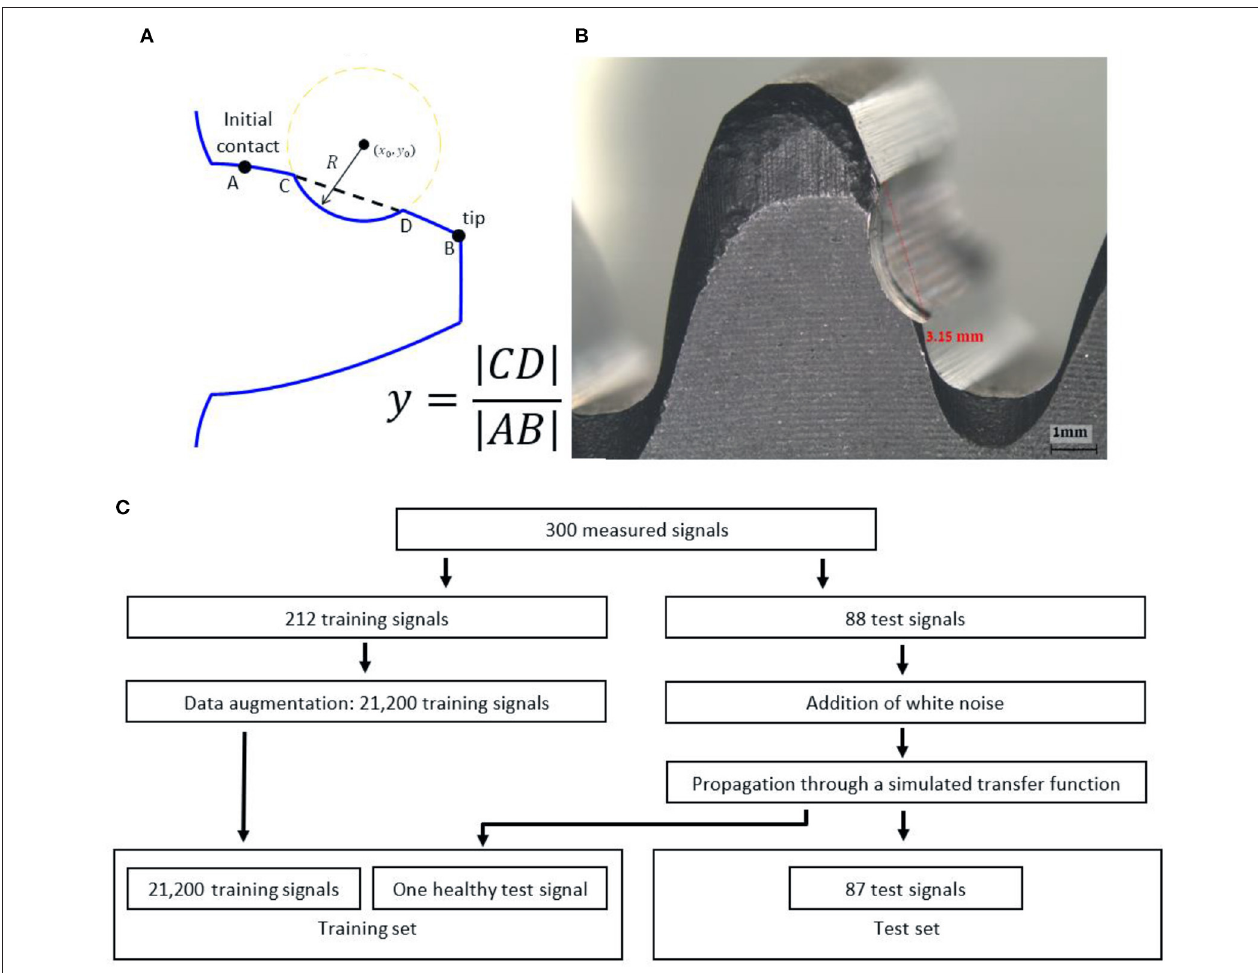
FIGURE 7 | Description of the dataset and explanation of the fault size. (A) Explanation about the definition of the fault size. (B) An example of a FTFF of a gear. (C) The block diagram of the generation of the dataset. The data augmentation includes a random cyclic rotation of the synchronous average signal because the initial time of the signal was random.